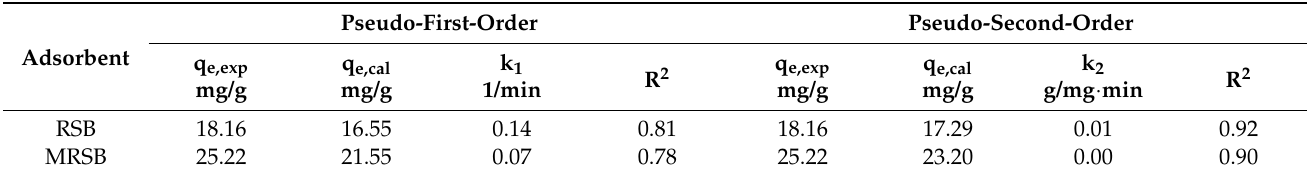
Table 4. Kinetic parameters of SO adsorption on RSB and